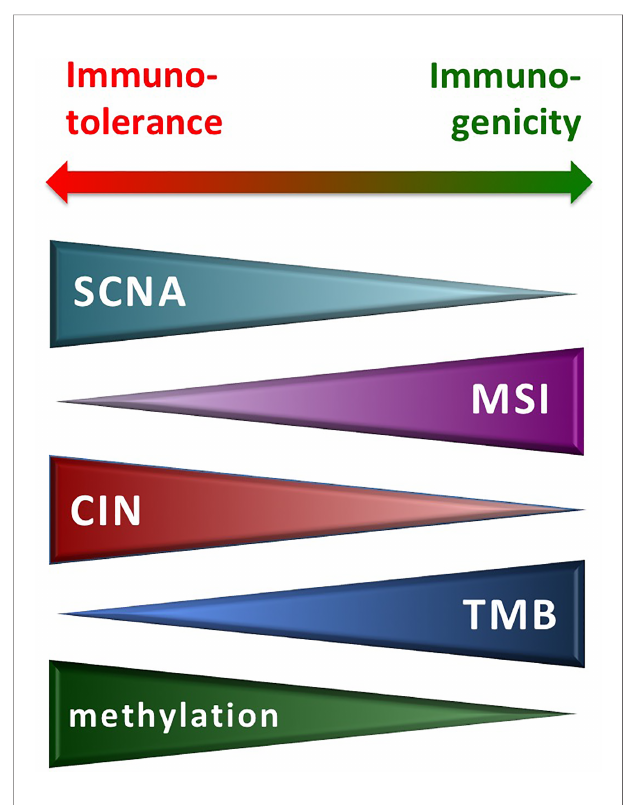
FIGURE 2 | Molecular alterations from genetic instability and immune reactivity. CIN, chromosomal instability; MSI, microsatellite instability; SCNA, somatic copy number alteration; TMB, tumor mutation